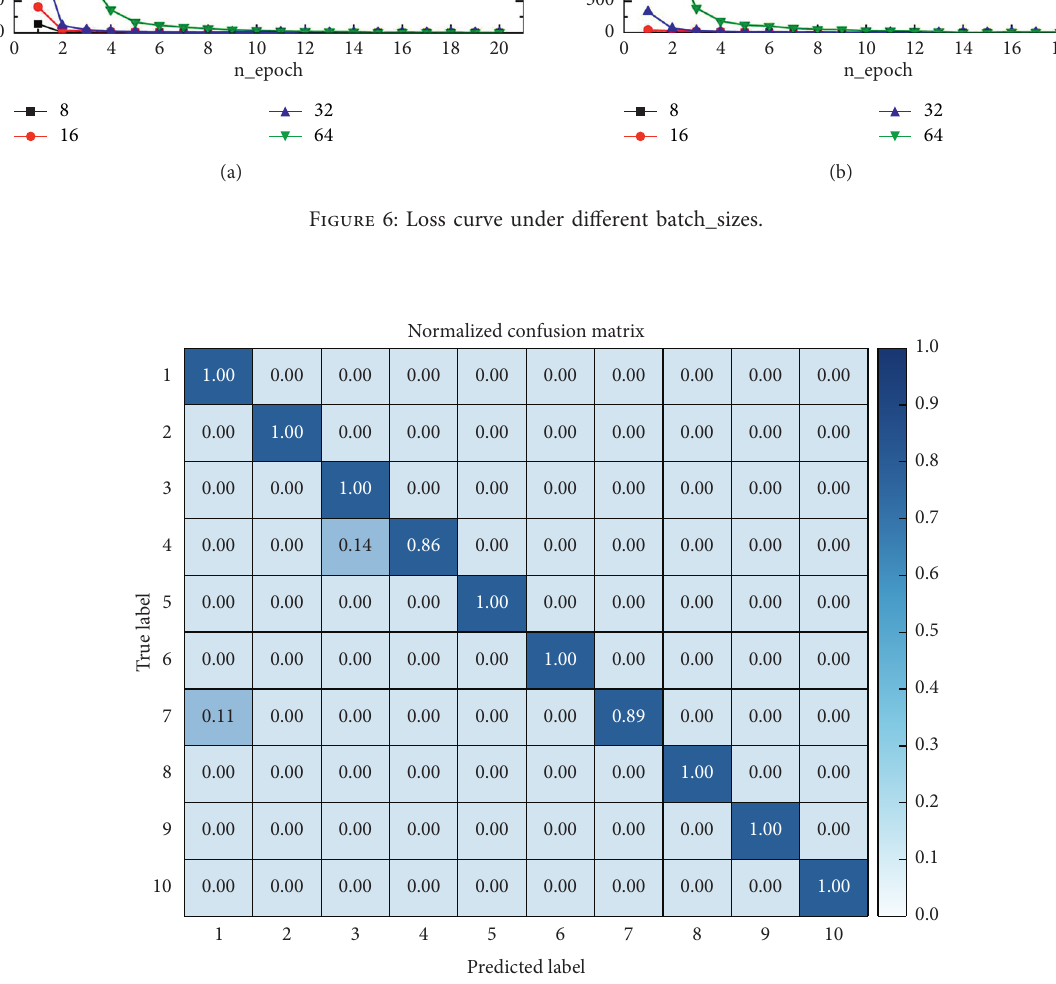
Figure 7: Identification results for 10 types of capsules: confusion matrix of CNN.